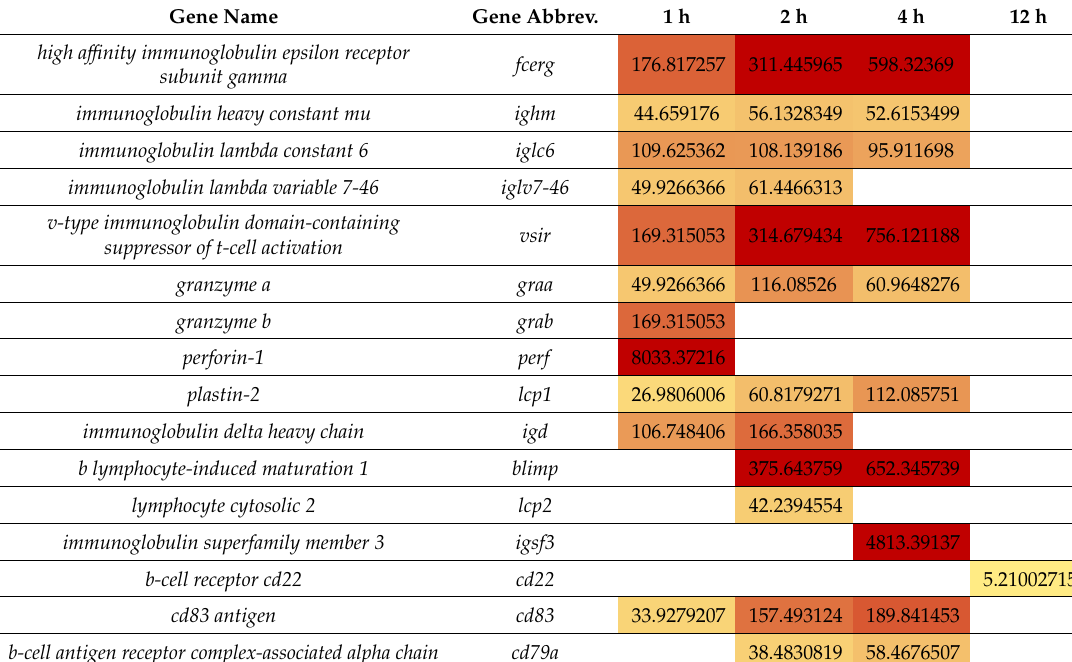
Table 8. Heat map showing a group of DE genes in turbot peritoneal cells at 1, 2, 4 and 12 hpi, including several genes related to B cells and cytotoxic T cells. Results are expressed as mean expression ratios of groups 1, 2 and 4 hpi vs. 0 h, or 12 hpi vs. PBS. There were no DE genes at 48 hpi. Red indicates increased gene expression levels; green indicates decreased levels.